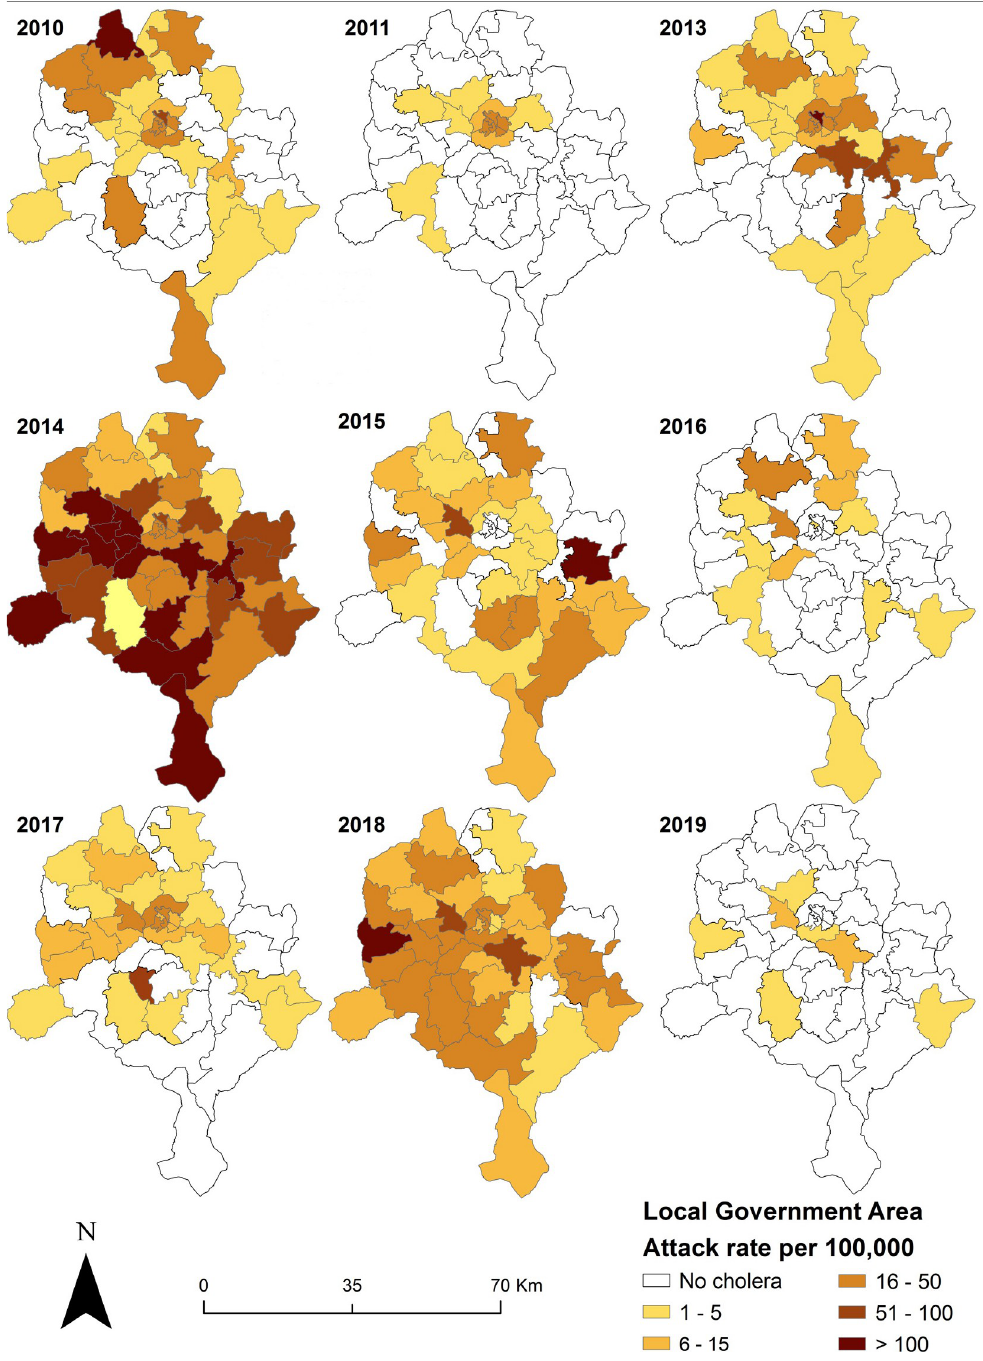
Fig 3. Geographic distribution of cholera attack rate at the Local Government Area (LGA) administrative level in Kano State from 2010–2019. No outbreaks were reported in 2012 while, cholera cases where reported from all LGAs in